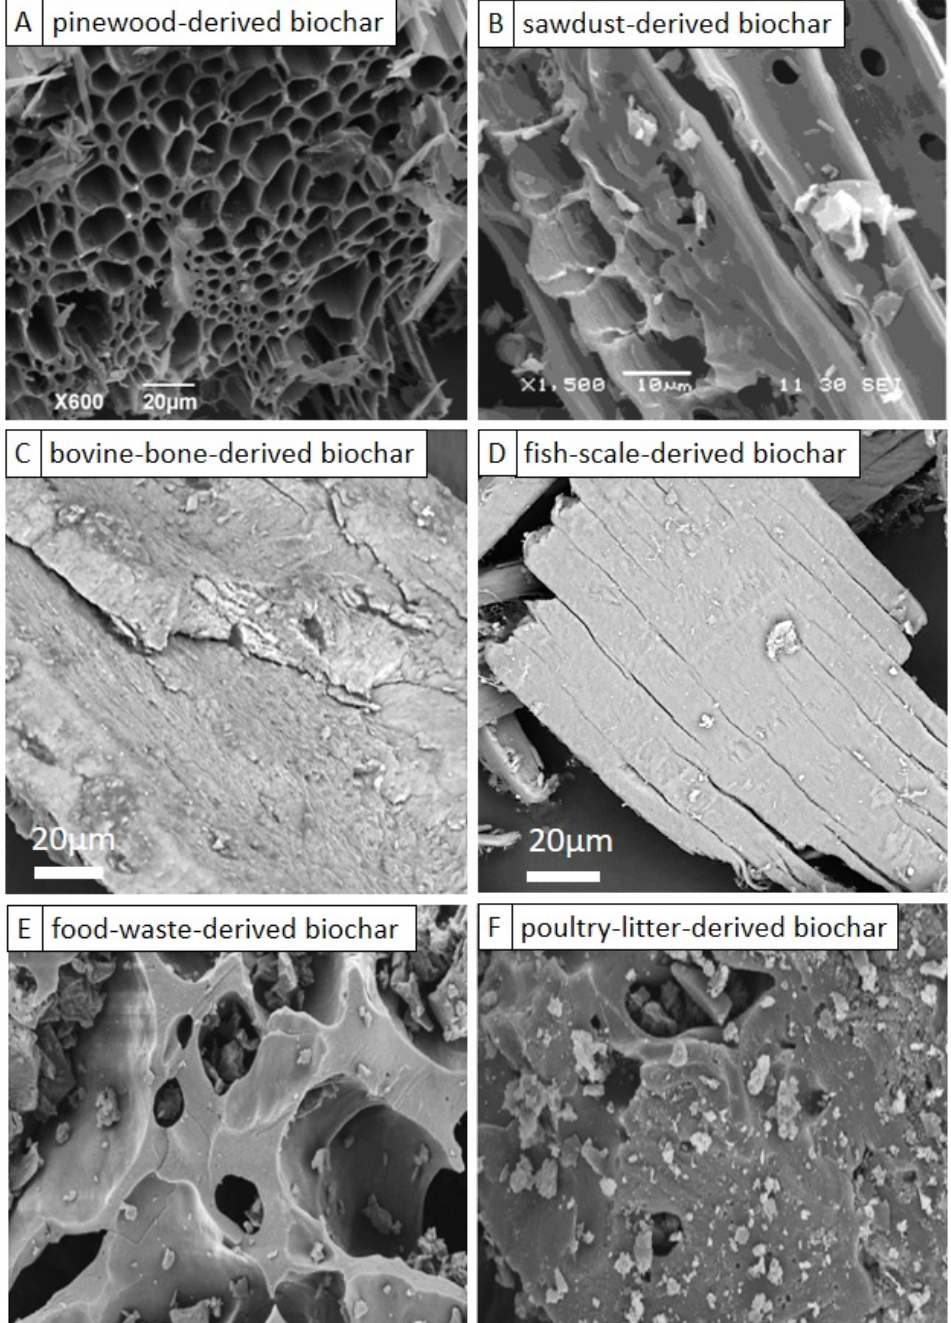
Figure 2. Surface morphology of some biochar, based on the different feedstocks [22–26]. ( A ) pine- wood-derived, ( B ) sawdust-derived, ( C ) bovine-bone-derived, ( D ) fish-scale-derived, ( E ) food-waste- derived, ( F ) poultry-litter-derived